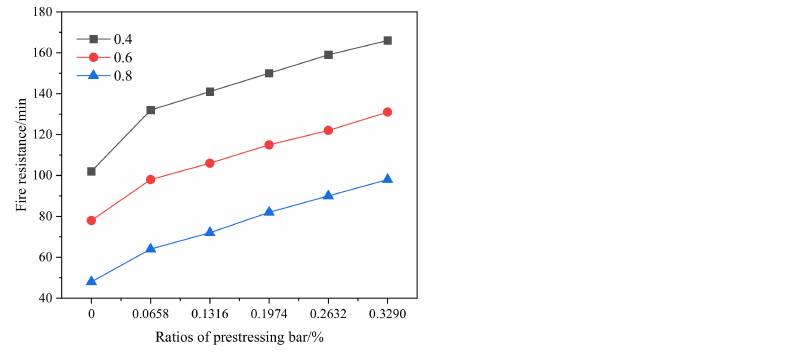
Figure 11. Curves of the effect of different ratios of prestressing bar on the fire resistance of T-beams.